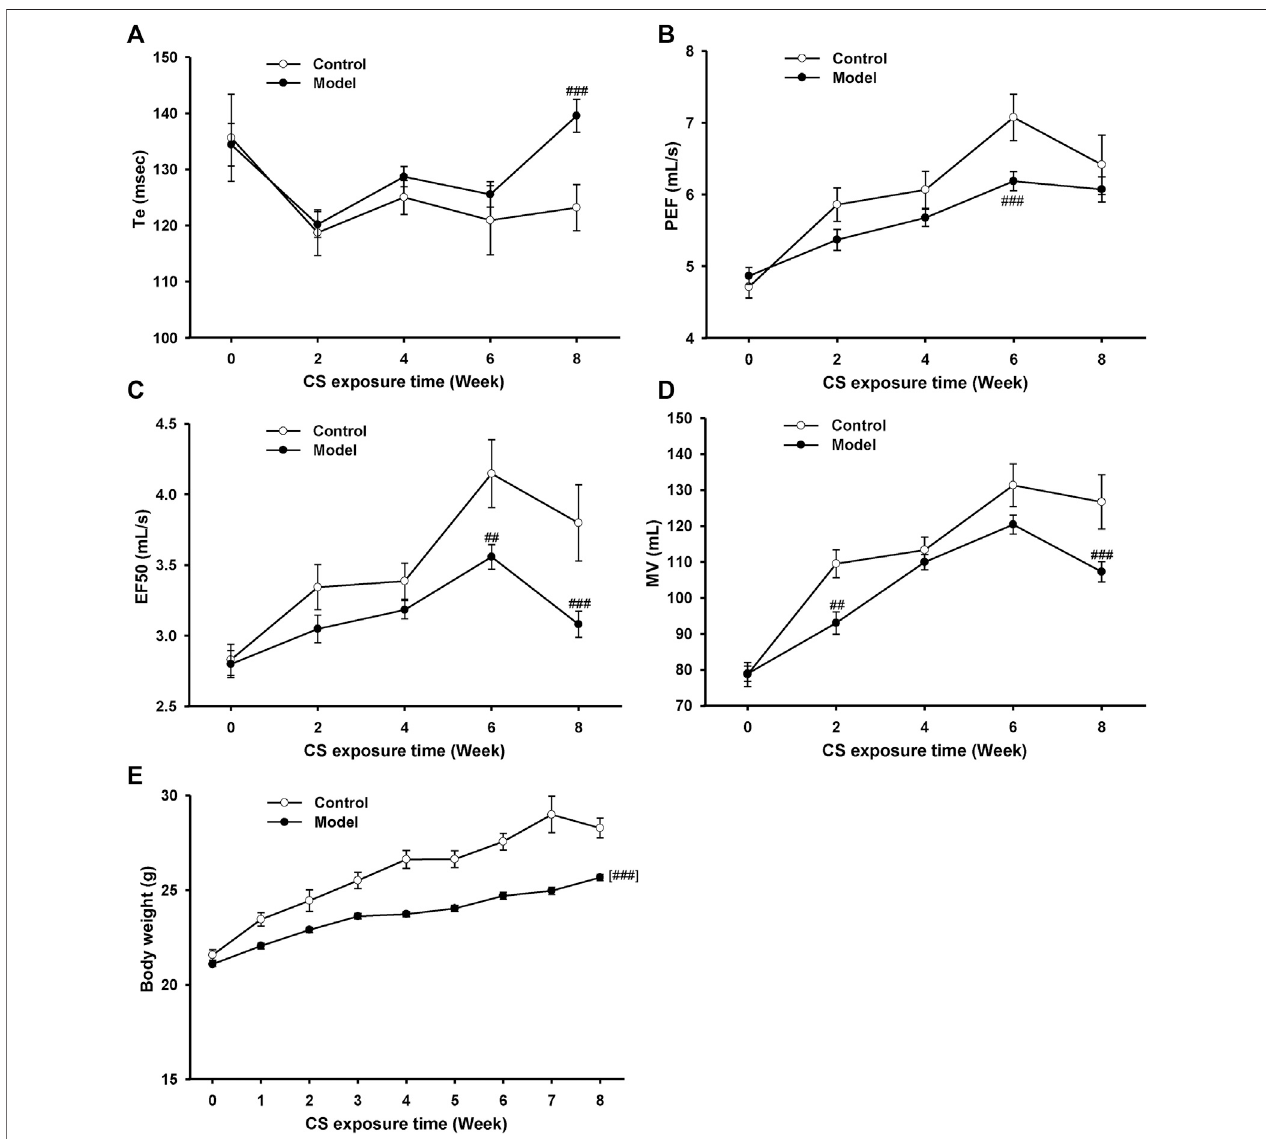
FIGURE 2 | Pulmonary function and body weight changes in mice exposed to cigarette smoke from 0 ∼ 8 weeks. (A) Expiratory time (Te), (B) peak expiratory fl ow (PEF), (C) expiratory fl ow at 50% tidal volume (EF50), (D) maximum minute ventilation (MV), and (E) body weight in control and model mice. Data are expressed as means ± SEM ( n (cid:1) 12 of control mice, n (cid:1) 60 of model mice). ## p < 0.01 and ### p < 0.001 vs. control group.